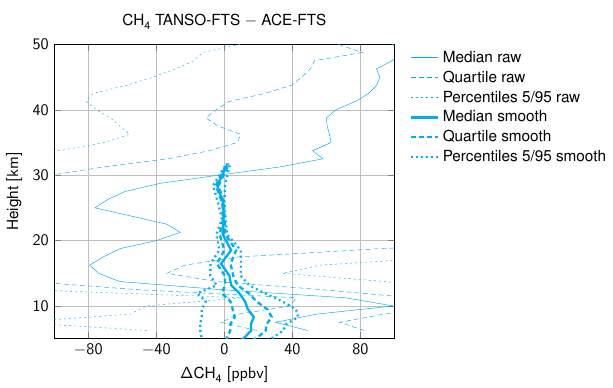
Figure 14. As in Fig. 10, but for ACE-FTS and TANSO-FTS. Note that collocations are limited to the quadrangle 60–90 ◦ N, 120– 40 ◦ W.